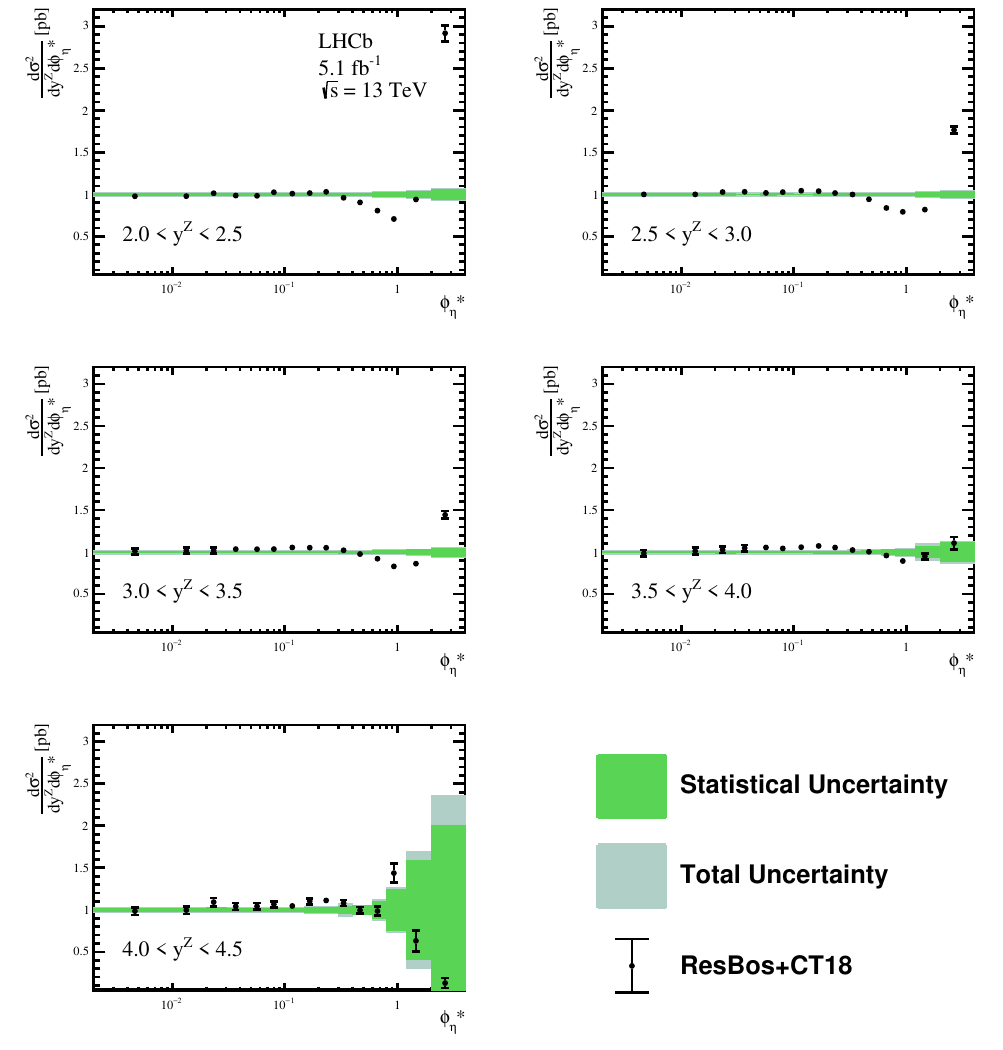
Figure 9 . Ratios of ResBos predictions to measurements as a function of φ ∗ with the horizontal bars showing the uncertainty from the